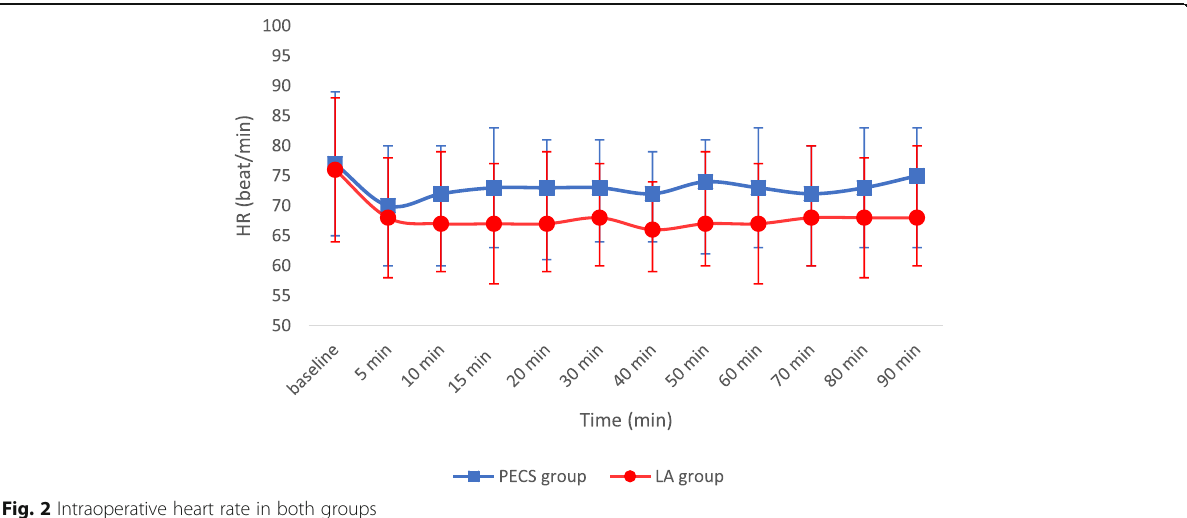
Fig. 2 Intraoperative heart rate in both